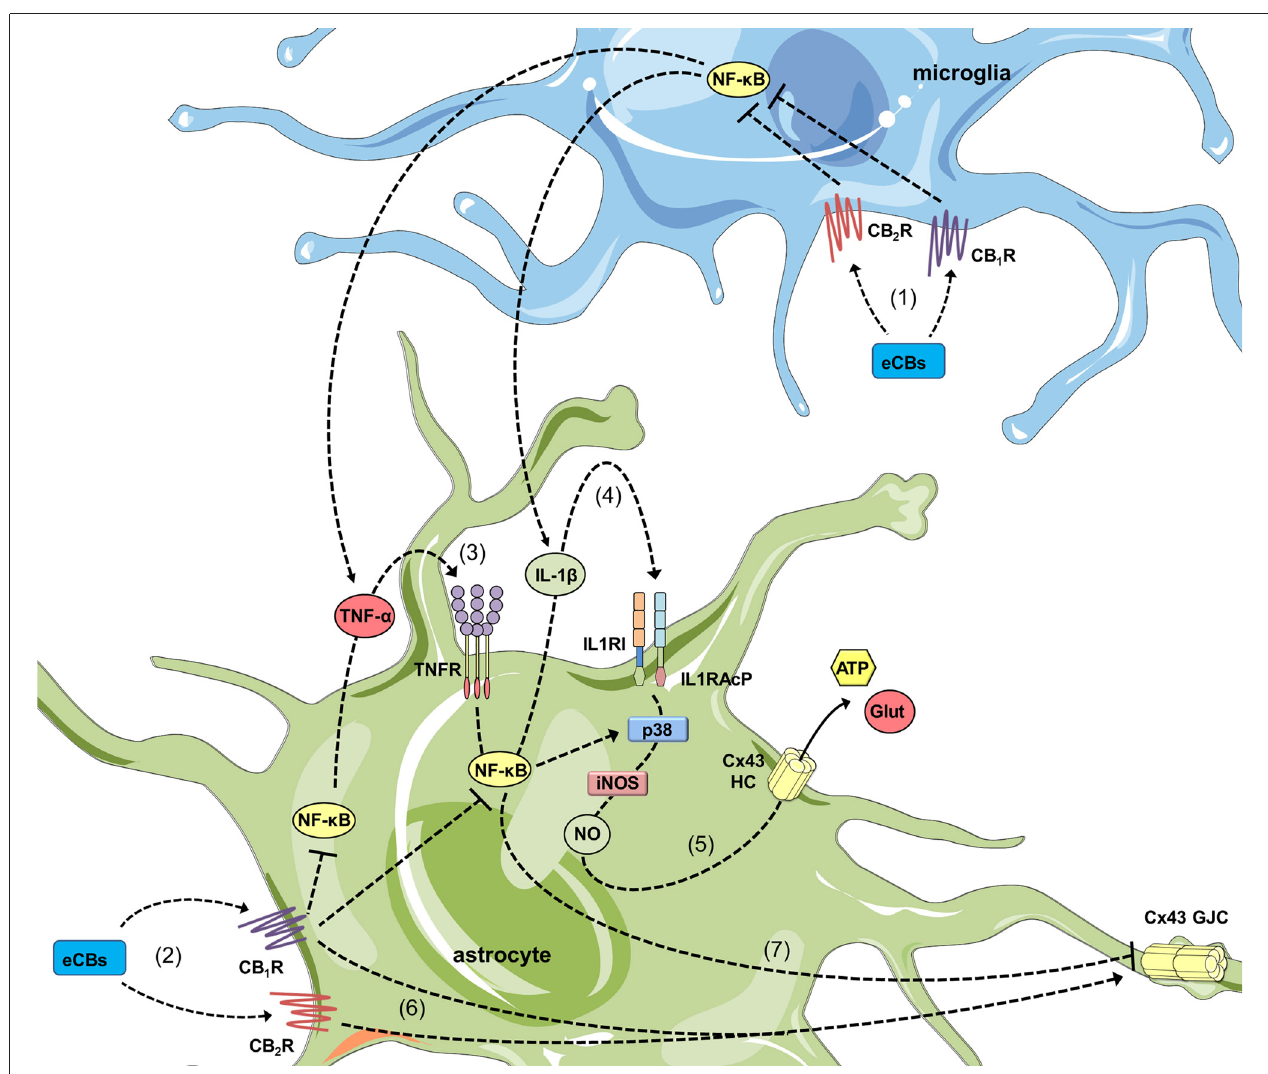
FIGURE 2 | Cannabinoids (CBs) prevent the opposite regulation of astroglial connexin-based channels evoked by inflammatory conditions. In activated microglia, endocannabinoids (eCBs) acting on CB 1 Rs/CB 2 Rs counteract the NF- κβ -dependent release of TNF- α and IL-1 β (1). In addition, in activated astrocytes, the stimulation of CB 1 Rs could also blunt the NF- κβ -mediated autocrine/paracrine release of TNF- α and IL-1 β (2) along with the corresponding activation of TNFR1 (3) and IL1RI/IL1RAcP (4). The latter results in the inhibition of p38 MAP kinase and nitric oxide (NO) production, as well as the consequent reduction in excitotoxic release of gliotransmitters (e.g., glutamate and ATP) through astroglial Cx43 hemichannels (5). In parallel, activation of CB 1 Rs/CB 2 Rs may neutralize the reduction in gap junction communication (6) evoked by pro-inflammatory conditions